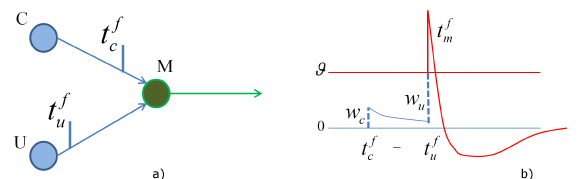
Figure 1: a) Excitatory postsynaptic potentials (EPSPs) of amplitude w c and w u at times t f c and t f u respectively. b) Action potential triggered at postsynaptic Motoneuron M .